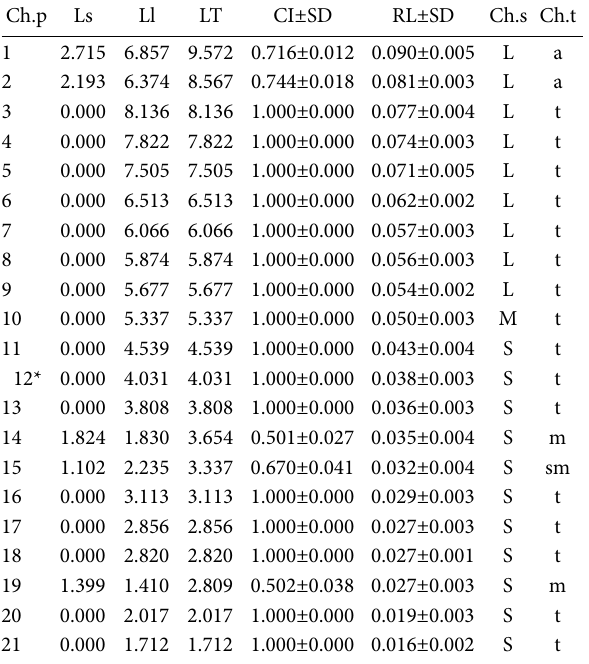
Table 2. Mean length of short arm chromosome (Ls), long arm chro- mosome (Ll), total chromosomes (LT), centromeric index (CI), rela- tive length (RL) and standard deviation (SD) of CI and RL from 20 metaphases of male and female Cyrtodactylus interdigitalis , 2 n = 42. Ch.p